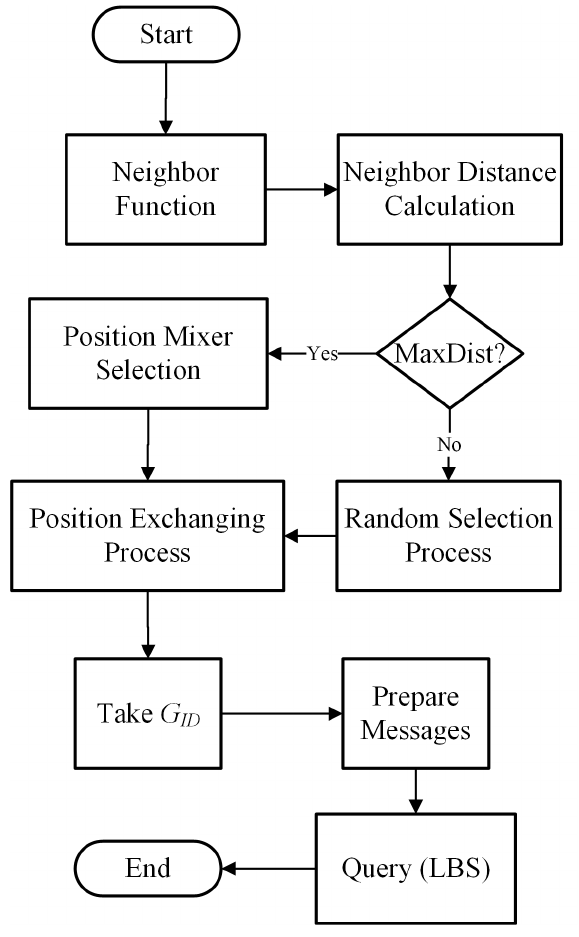
Figure 10. LBS query flow